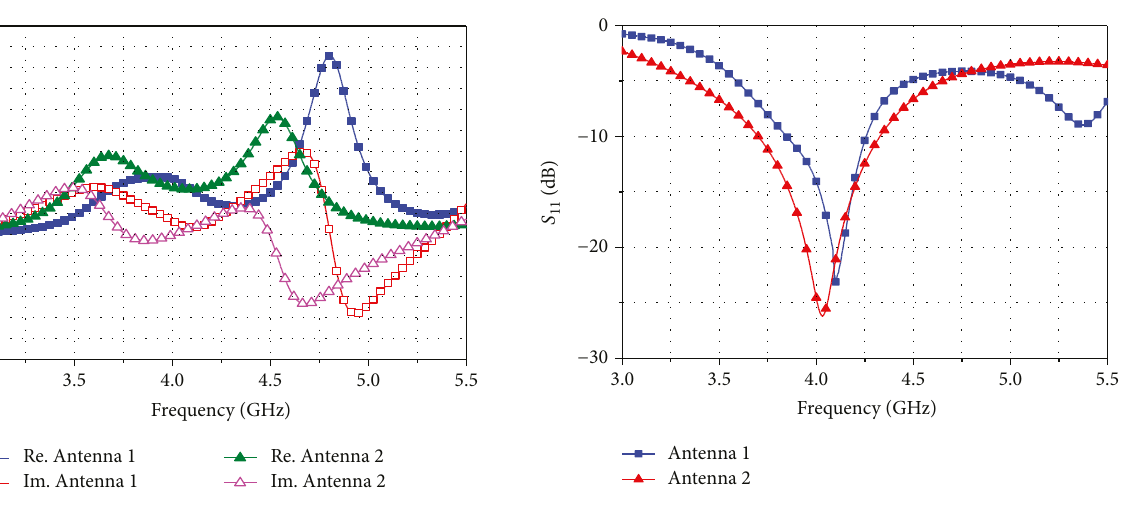
| of antennas in Figure 11